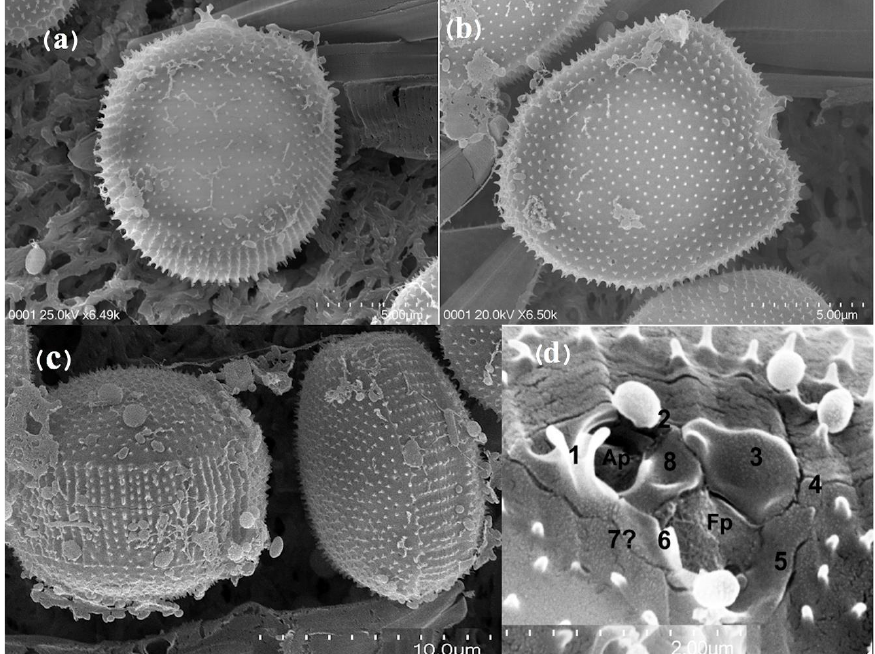
Figure 6. Images from scanning electron microscopy (SEM) of the IMP-BG 450 strain of P. cordatum ; ( a ) view of the left side valve showing the apical collar, ( b ) right side valve view, ( c ) intercalary band and ( d ) periflagellar platelets (1: forked tooth; 2: small tooth; 3, 4, 5, 6, 7?, 8; Ap: auxiliary pore; Fp: flagellar pore).